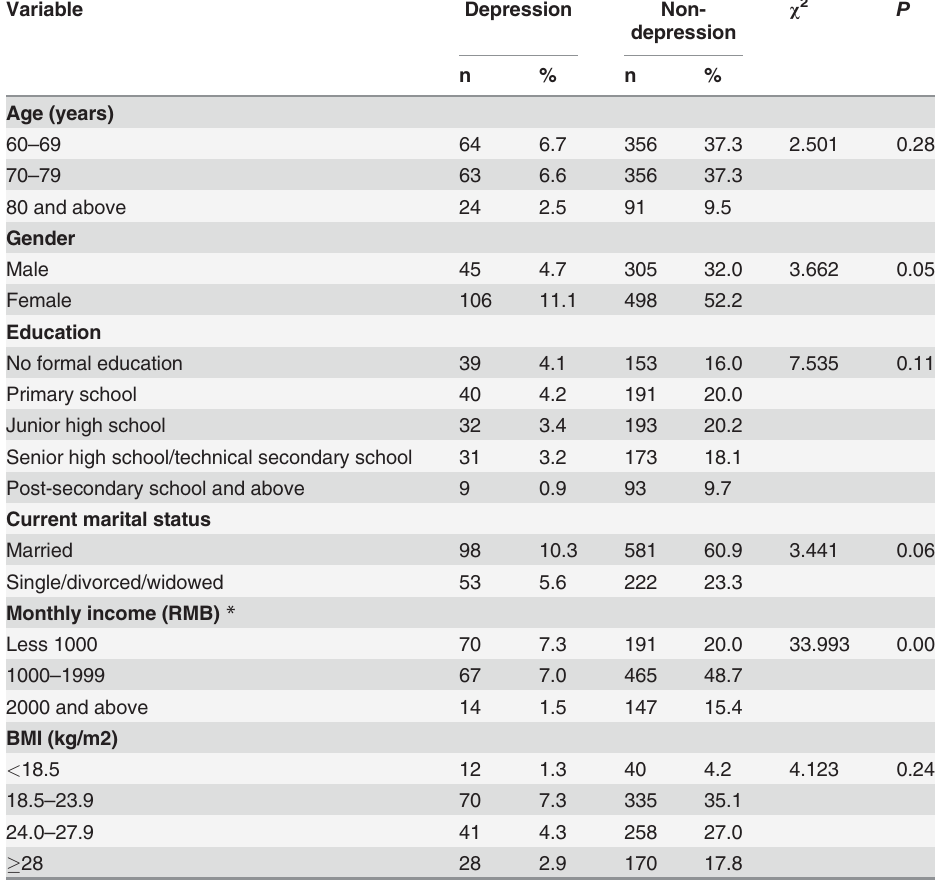
Table 3. Participants ’ characteristics by depression status (n =